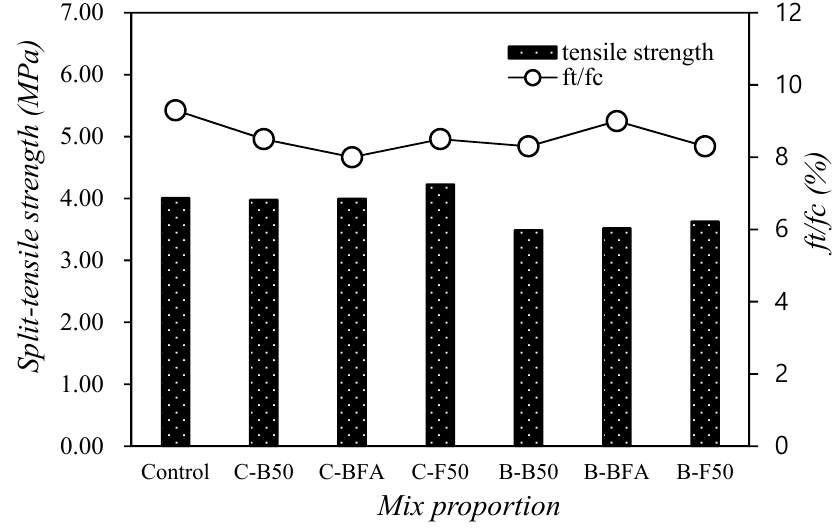
Figure 6. Tensile strength of mortar with mixed fine aggregates at 28 days.